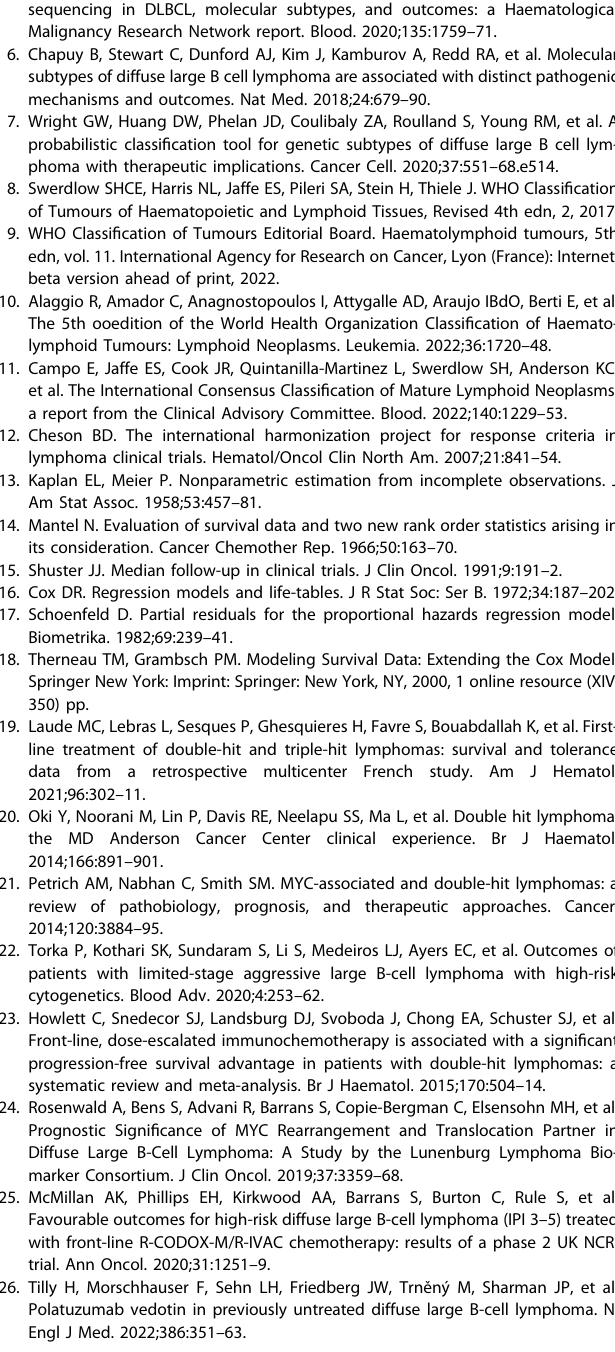
Fig. 1 Kaplan – Meier estimates for overall survival and time to next treatment for Myc rearranged DLBCL patients in this study. A Overall survival in all patients, including MYC - BCL2 double hit and triple hit, MYC rearranged and MYC - BCL6 diffuse large B-cell lymphoma; B overall survival for patients with MYC - BCL2 double hit and triple hit, MYC rearranged and MYC - BCL6 diffuse large B-cell lymphoma treated with all types of chemoimmunotherapy; C time to next treatment for patients with MYC - BCL2 double hit and triple hit, MYC rearranged and MYC - BCL6 diffuse large B-cell lymphoma treated with all types of chemoimmunotherapy; D overall survival for patients treated with RCHOP or intensive therapy strati fi ed by MYC - BCL2 double hit and triple hit, MYC rearranged and MYC - BCL6 translocation status; E time to next treatment for patients treated with R-CHOP or intensive therapy strati fi ed by MYC - BCL2 double hit and triple hit, MYC rearranged and MYC - BCL6 translocation status; F overall survival in all patients with MYC - BCL2 double hit and triple hit diffuse large B-cell lymphoma strati fi ed by treatment with RCHOP or intensive therapy; G time to next treatment in all patients with MYC - BCL2 double hit and triple hit diffuse large B-cell lymphoma strati fi ed by treatment with RCHOP or intensive